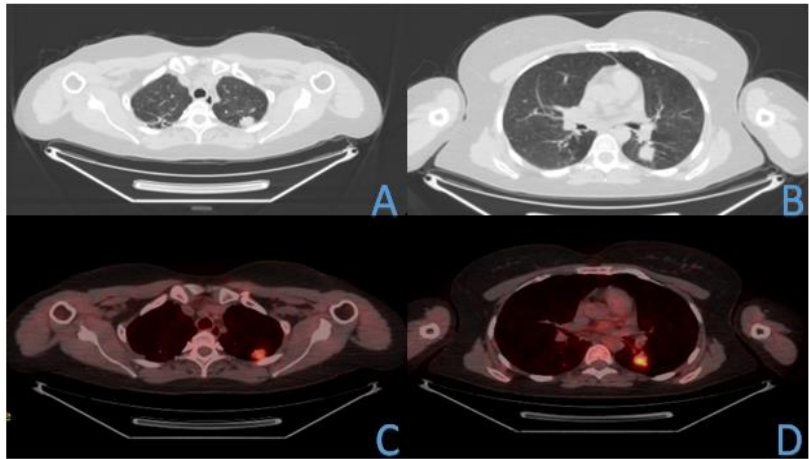
Figure 1. A, B: Thorax-CT scans reveal two lobules contoured lesions in the left upper lobe apicoposterior segment and left lower lobe superior segment. C, D: PET/CT scans reveal malignant uptake, the standardized uptake values were 5,1 and 7,1, in the left upper and left lower lesions